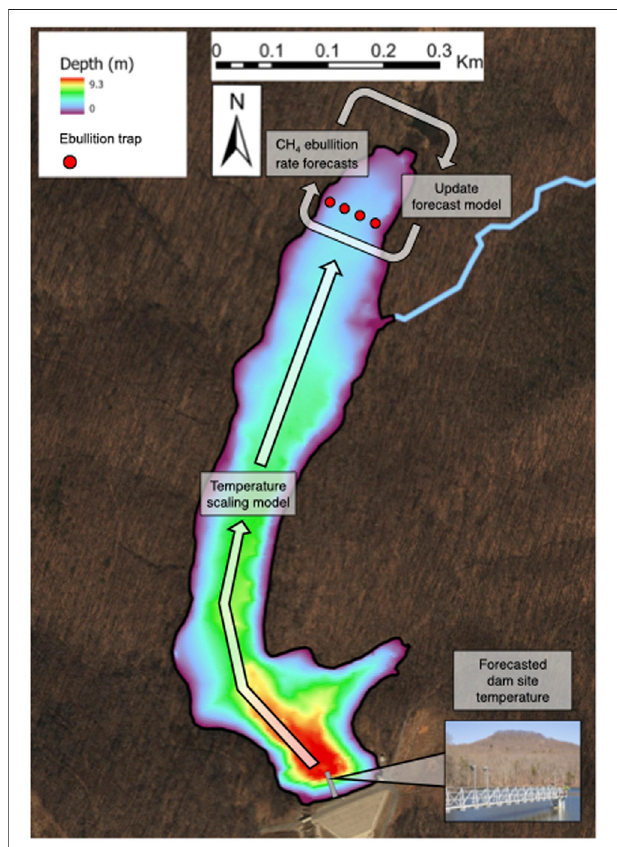
FIGURE1| ThebathymetryofFallingCreekReservoirsuperimposed by adepictionofhowourforecastwork fl owmappedspatiallyfromthedamtothe upstream transect where CH 4 ebullition rates were forecasted. Our forecast work fl ow used water temperature forecasts from the dam site in the reservoir (following Thomas et al., 2020). The water temperature forecasts were scaled to an upstream transect (denoted by red dots on map) to generate near-term iterative CH 4 ebullition rate forecasts. Simultaneously, direct observations from ebullition traps were used to iteratively update the forecast model via data